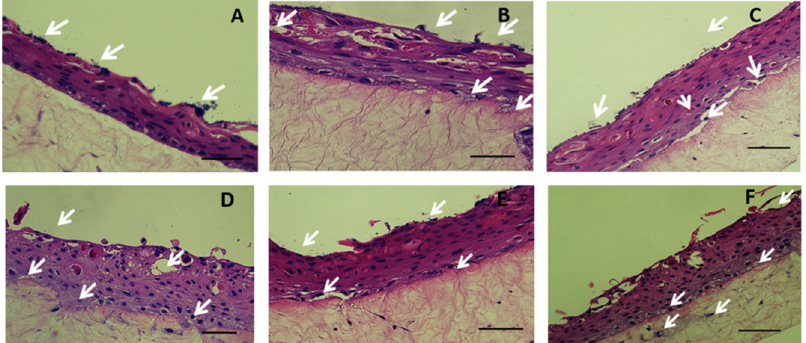
Figure 3. H&E stain of histological section of skin model at 48 h after inoculation with MRSA strain ST8 ( A ), ST30 ( B ), ST59 ( C ), ST22 ( D ), ST45 ( E ) and ST239 ( F ), respectively. White arrows show microcolonies of bacteria. Scale Bar depicts 50 µm.